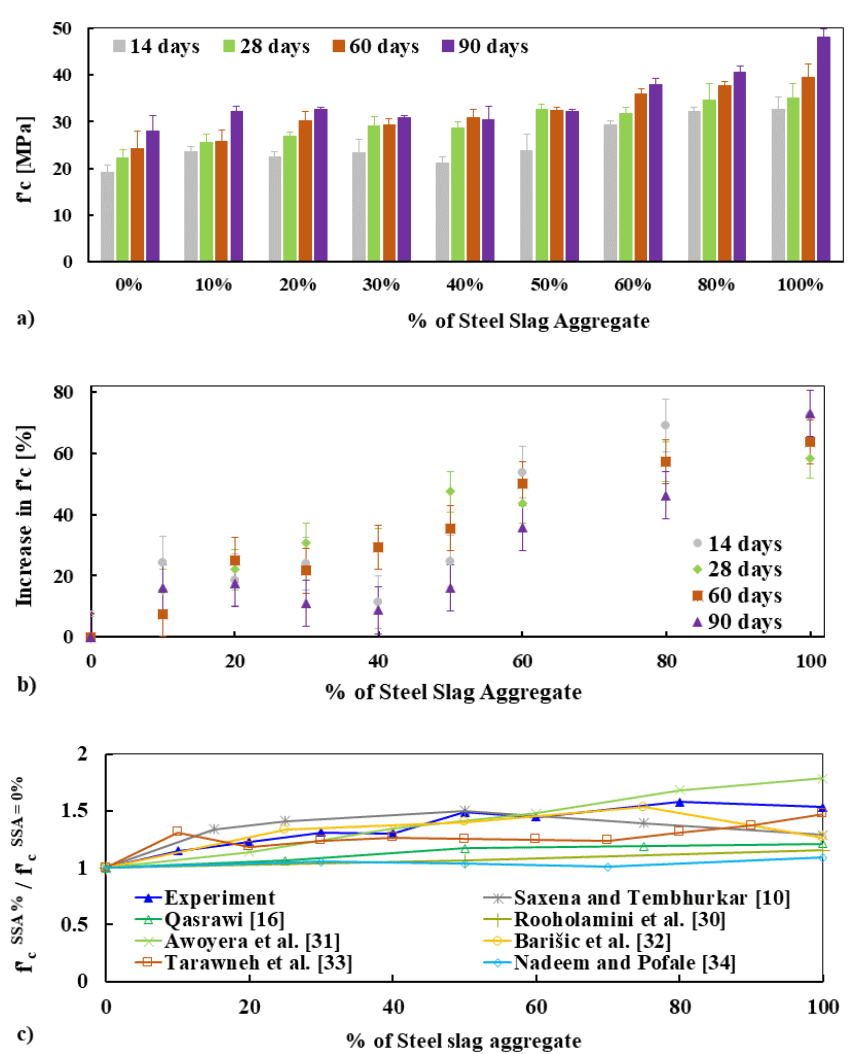
Figure 7. Compressive strength 𝑓 𝑐′ ( a ), an increase in 𝑓 𝑐′ as a function of SSA ( b ), and normalized 𝑓 𝑐′ of concrete mixes measured at 28 days were compared with other results found in the literature ( c ), respectively.